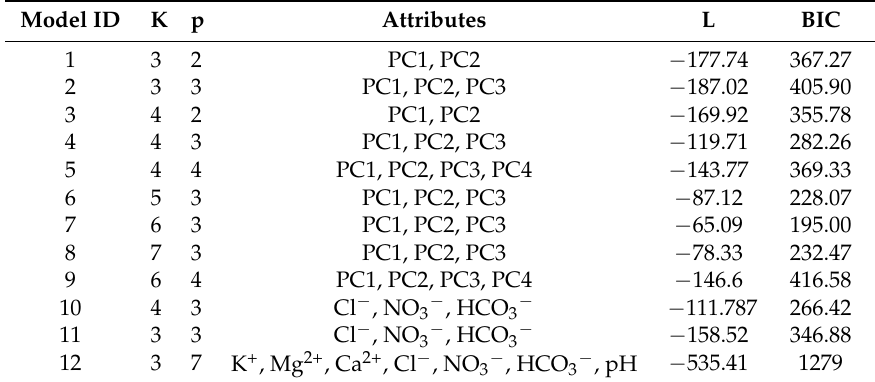
Table 3. Twelve candidate models and their associated likelihoods and BIC values. Model